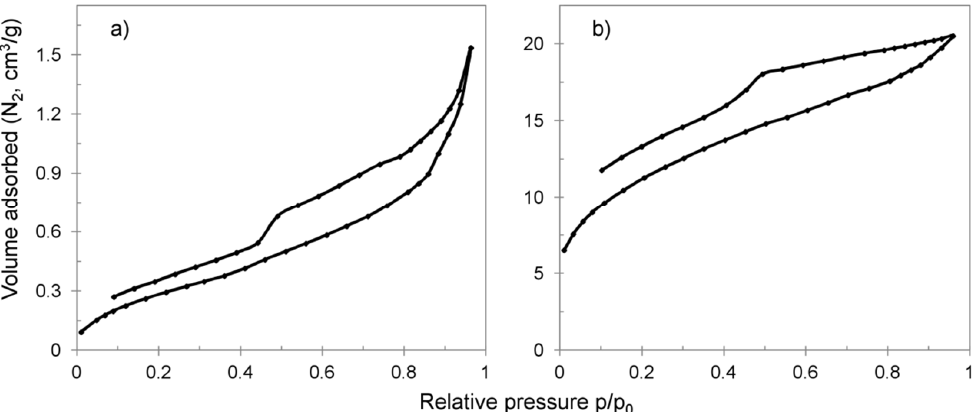
Figure 5. Nitrogen adsorption/desorption isotherms for hybrid materials: ( a ) CMW1#MnO 2 , ( b ) CWM3#MnO 2.